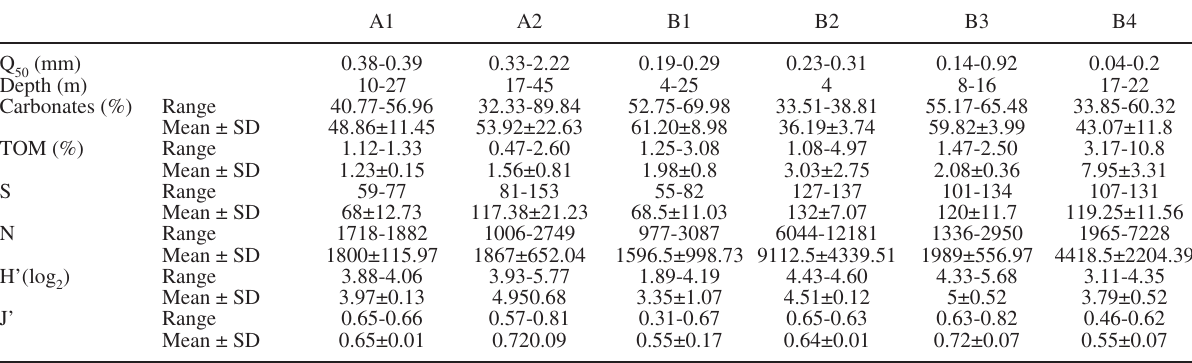
Table 2. – Summary of abiotic and biotic characteristics for each assemblage defined by multivariate analyses. TOM: total organic matter; S: number of species; N: total abundance per 0.28 m 2 ; H’: Shannon Wiener’s diversity index; J’: Pielou’s evenness.